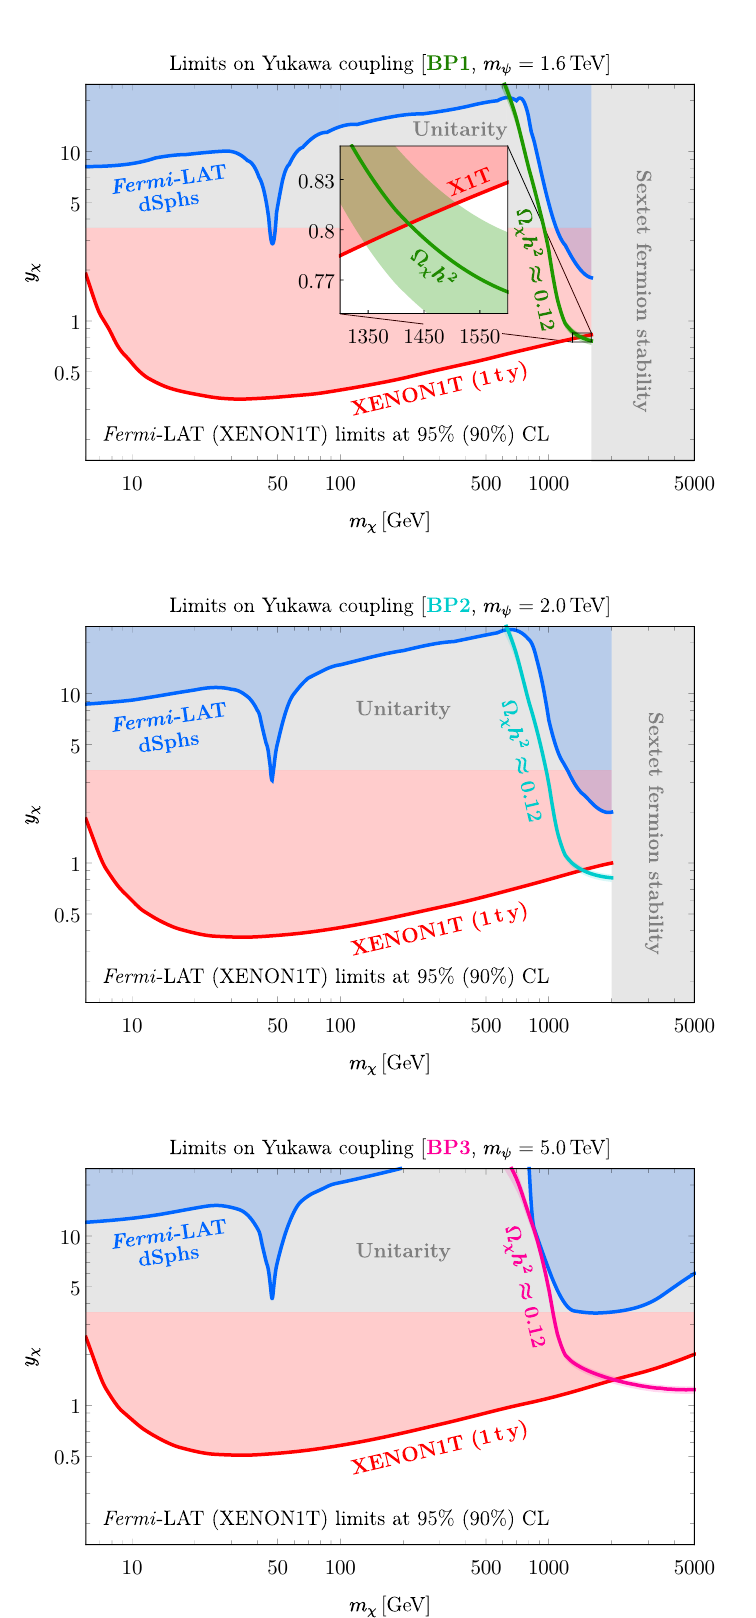
Figure 19 . Limits on y χ as a function of m χ in each benchmark, including direct-detection bounds from XENON1T and the Fermi -LAT limits from